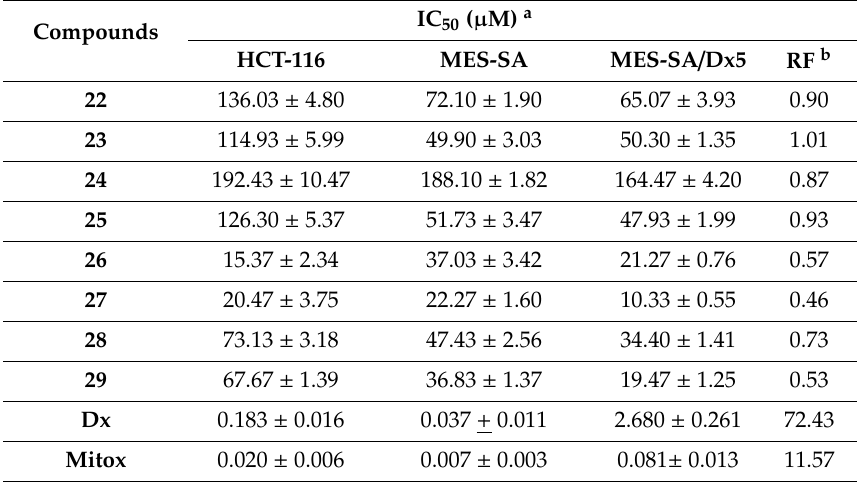
Table 1. Inhibition of proliferation (IC 50 values in µ M) of compounds 22 – 29 against HCT-116, MES-SA, and MES-SA / DX5 human tumor cell lines determined after 72 h of